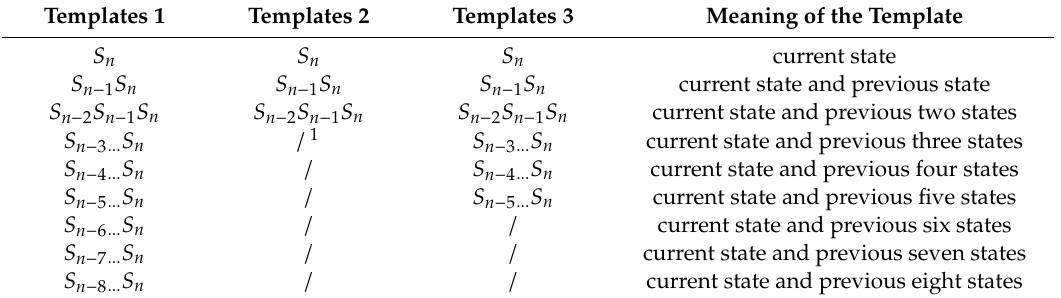
Table 1. List of feature